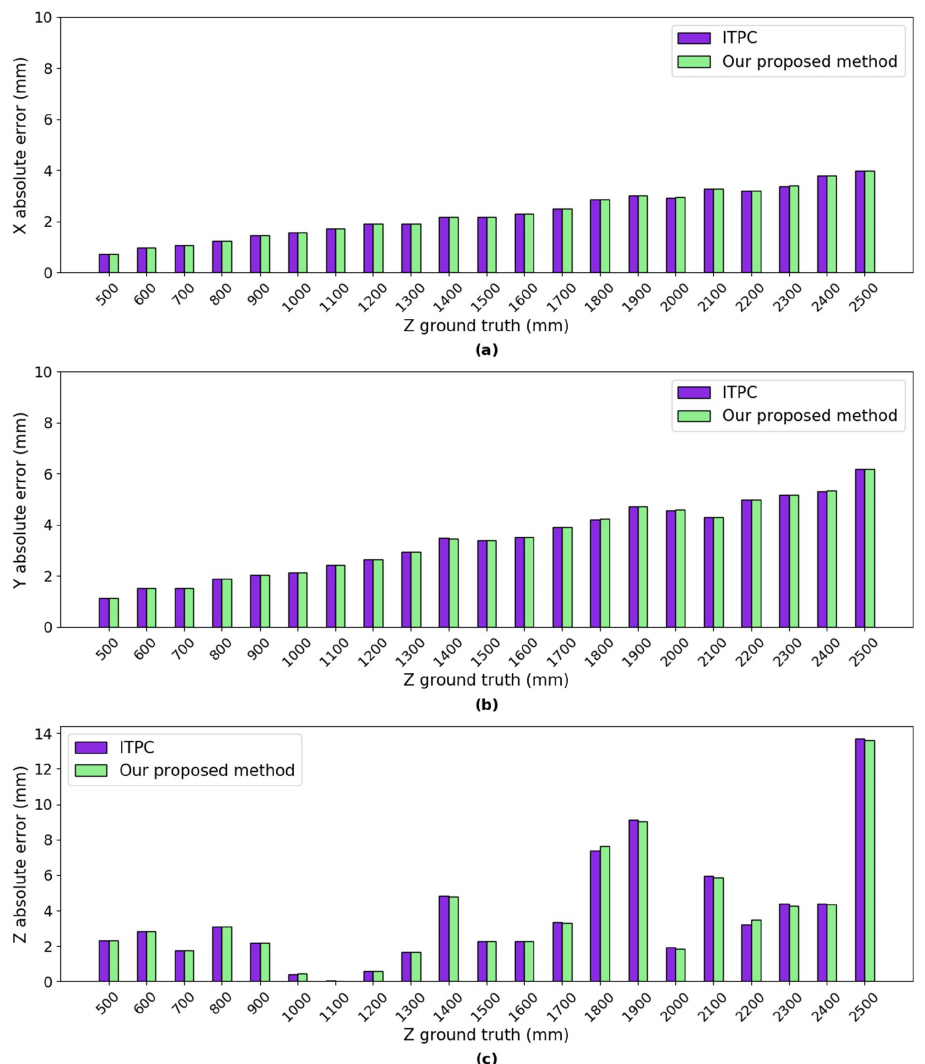
Figure 6. The absolute error of the mean of the estimated 3D coordinates using our proposed method and integrated two-pose calibration (ITPC) method w.r.t ground truth respectively. ( a ) absolute error in X axis; ( b ) absolute error in Y axis; and,( c ) absolute error in Z